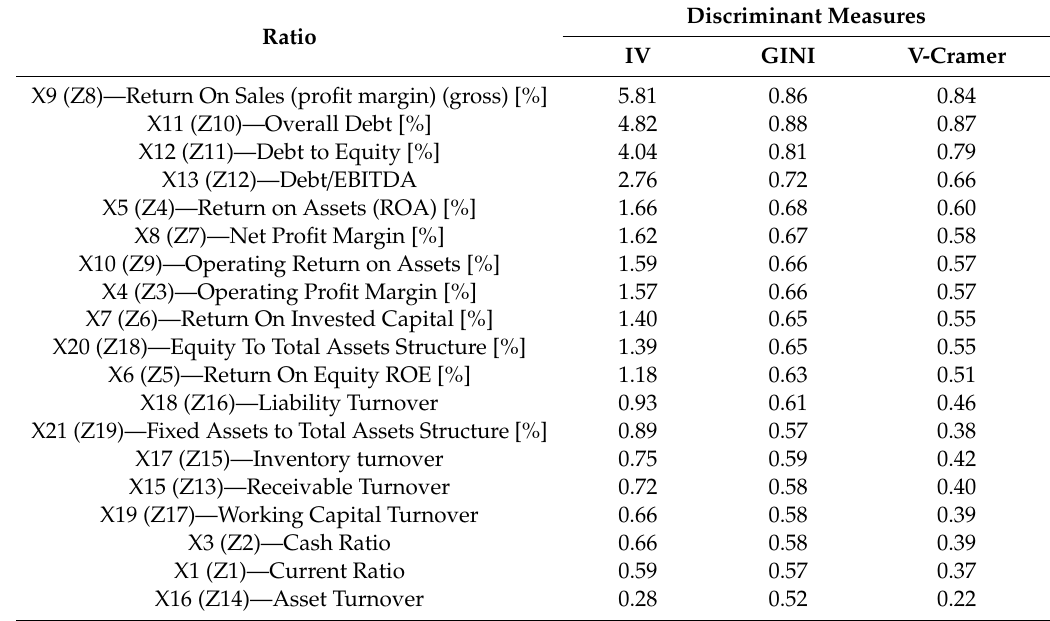
Table 3. Discriminant capability measures—ranking of